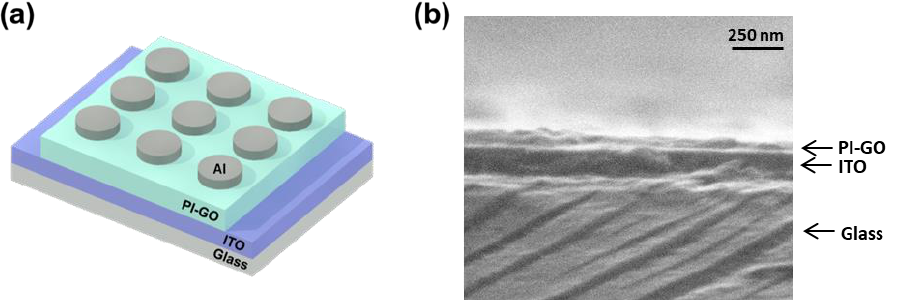
Figure 5. ( a ) Schematic structure of the ITO/PI-GO/Al device; ( b ) FE-SEM image of the PI-GO on ITO glass.